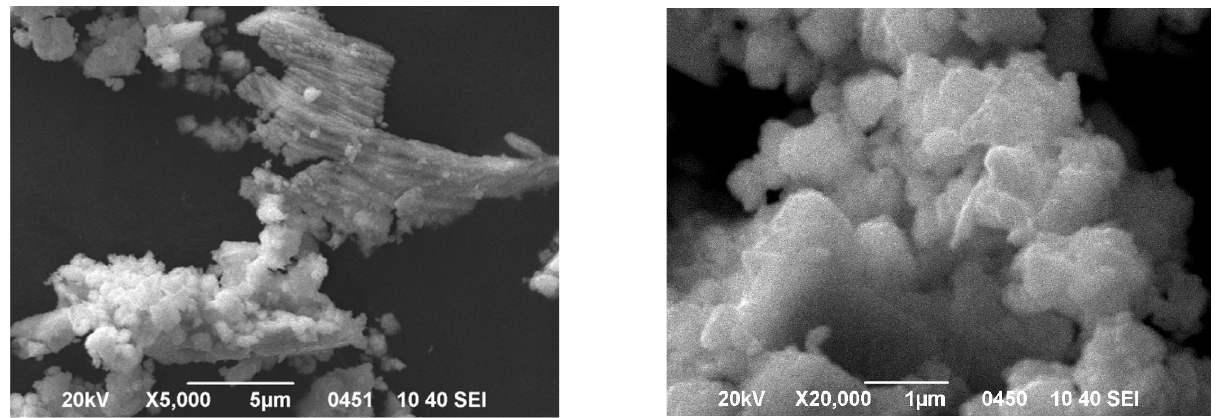
Figure 1. SEM image of POM-powder surface in secondary electron mode: left—×5000; right—×20,000.